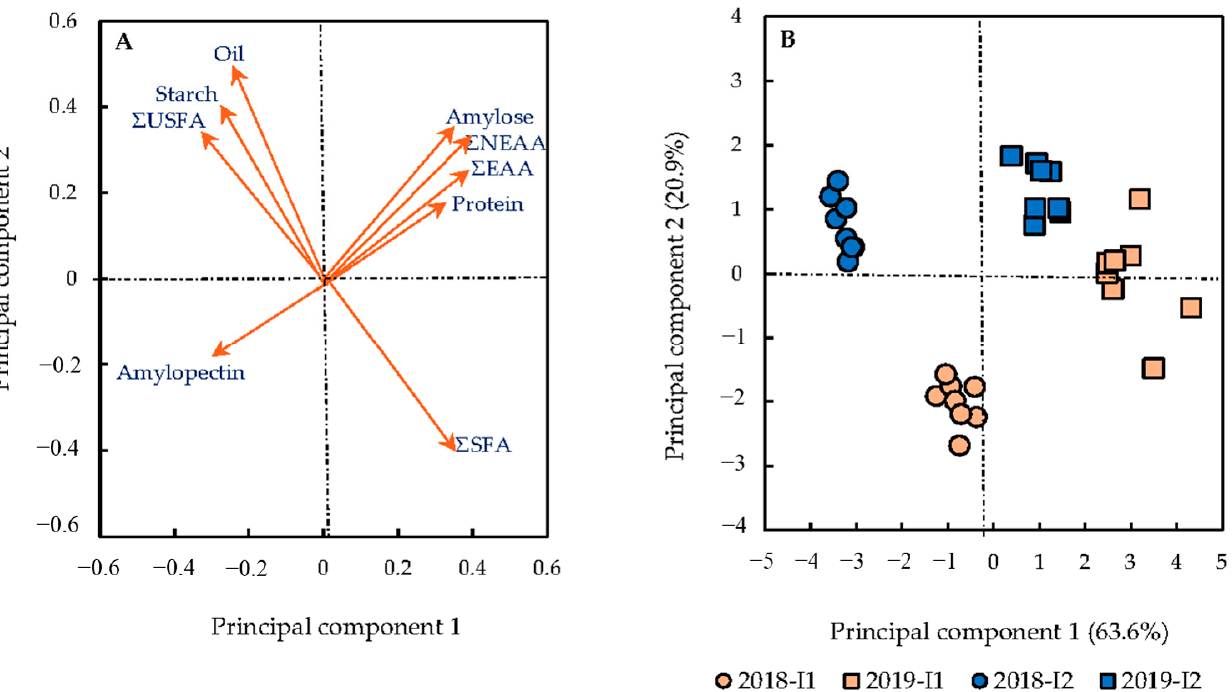
Figure 3. Plots of principal component 1 versus principal component 2 based on measured maize grain quality characteristics: the loading plot ( A ) shows the eigenvector of each characteristic. The score plot ( B ) shows the means, grouped by year and irrigation treatment. Each marker represents the mean of replicates in the field. Abbreviations; I1, Irrigation at 12-day intervals; I2, Irrigation at 6 day-intervals; Σ EAA, total essential amino acids; Σ NEAA, total non-essential amino acids; Σ SFA, total saturated fatty acids; Σ USFA, total unsaturated fatty acids.